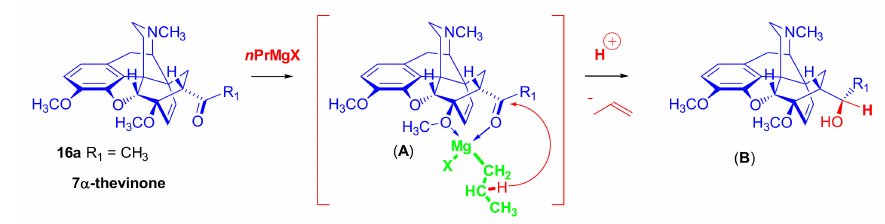
Figure 28. Mechanism of the Grignard reduction of 7 α -acyl-6,14-ethenomorphinans.